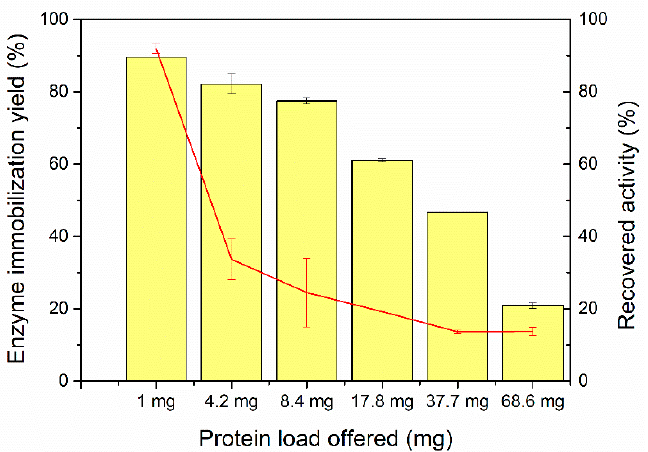
Figure 5. Effect of protein loading on enzyme immobilization yield (bars) and recovered activity (line) in the immobilization of NPD on agarose-glyoxyl at 20 °C, pH 10.0 and 24 h reaction time.